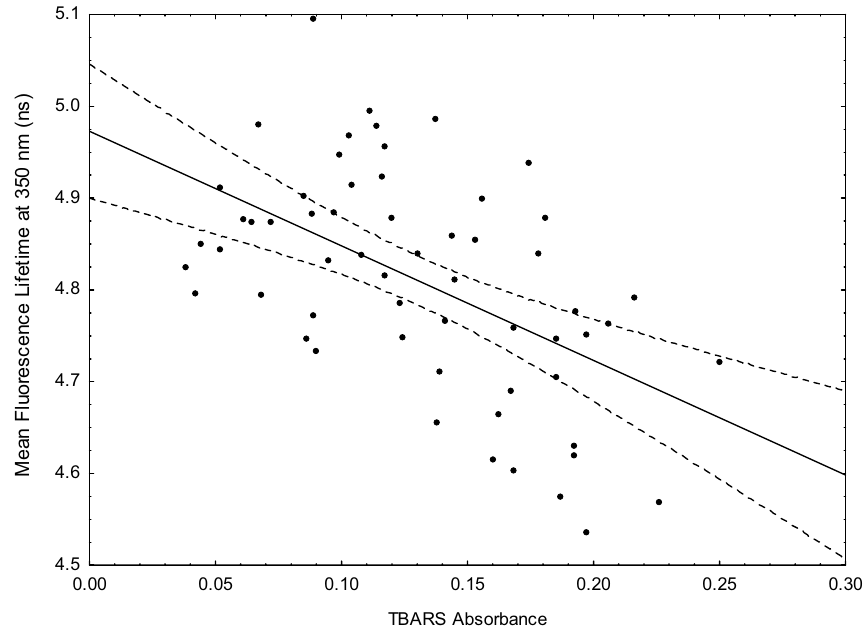
Figure 3. Dependence between mean fluorescence lifetime (mFLT) at 350 nm and TBARS absorbance at 532 nm in healthy plasma donors. The dashed lines represent the 95% confidence intervals for the regression